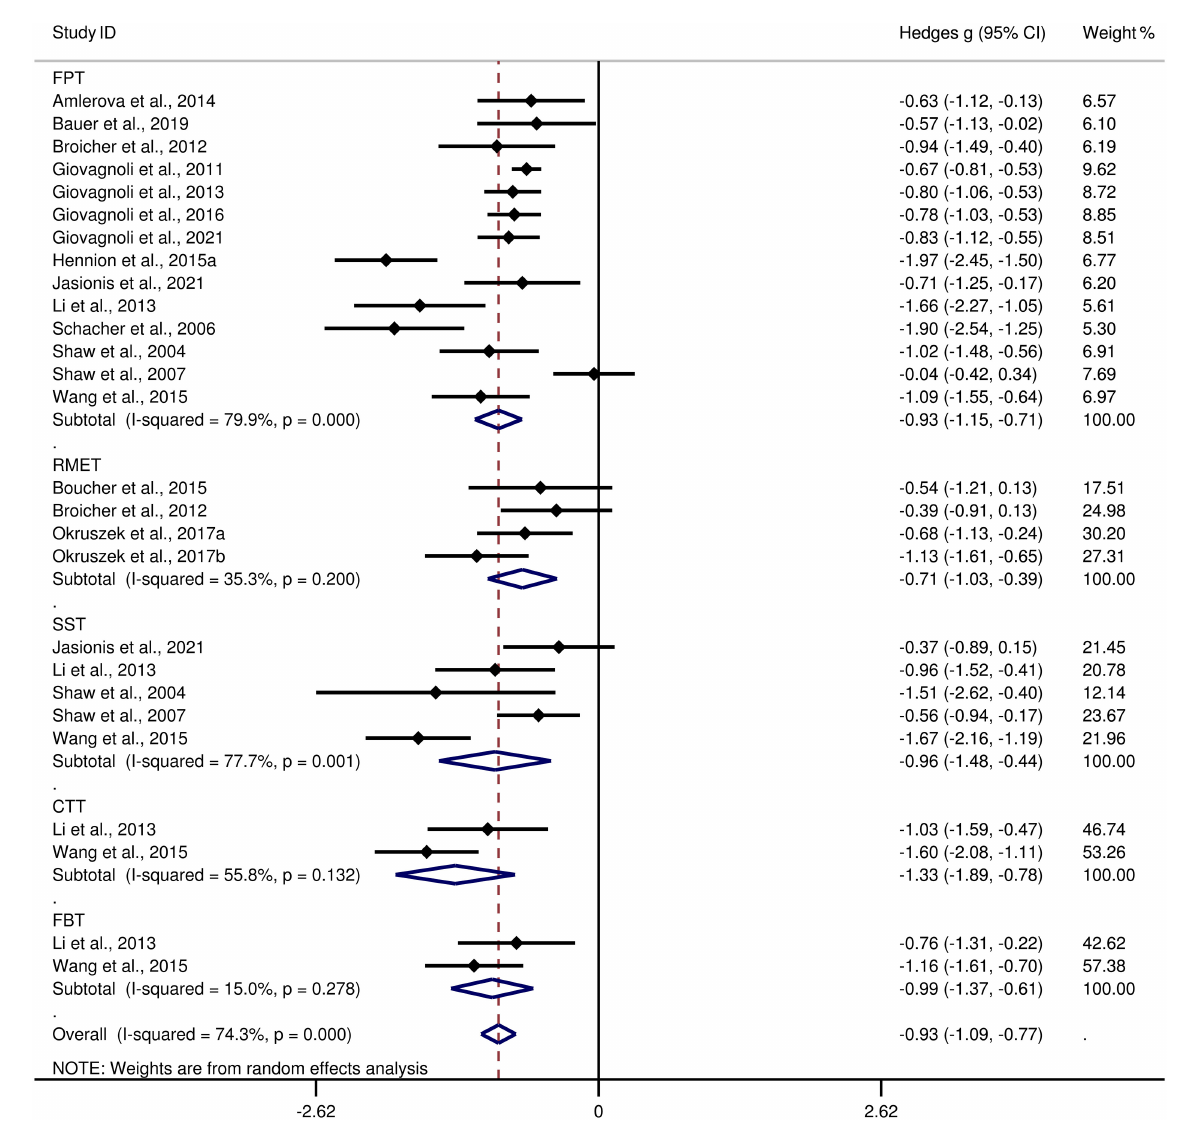
FIGURE4 Forest plots showing effect size estimates (Hedges g) for individual ToM tasks differences between adults with TLE and healthy controls. ToM, theory of mind; CI, confidence interval; TLE, temporal lobe epilepsy. CTT, cartoon ToM task; SST, strange stories task; FPT, faux pas task;